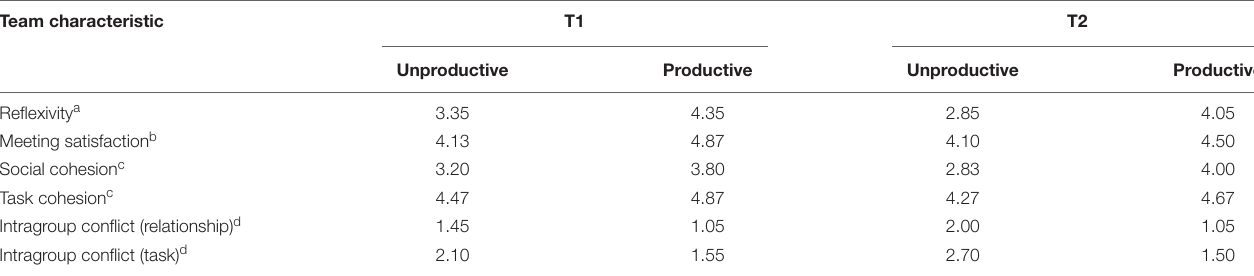
TABLE 2 | Aggregated scores on team characteristics for each team at T1 and